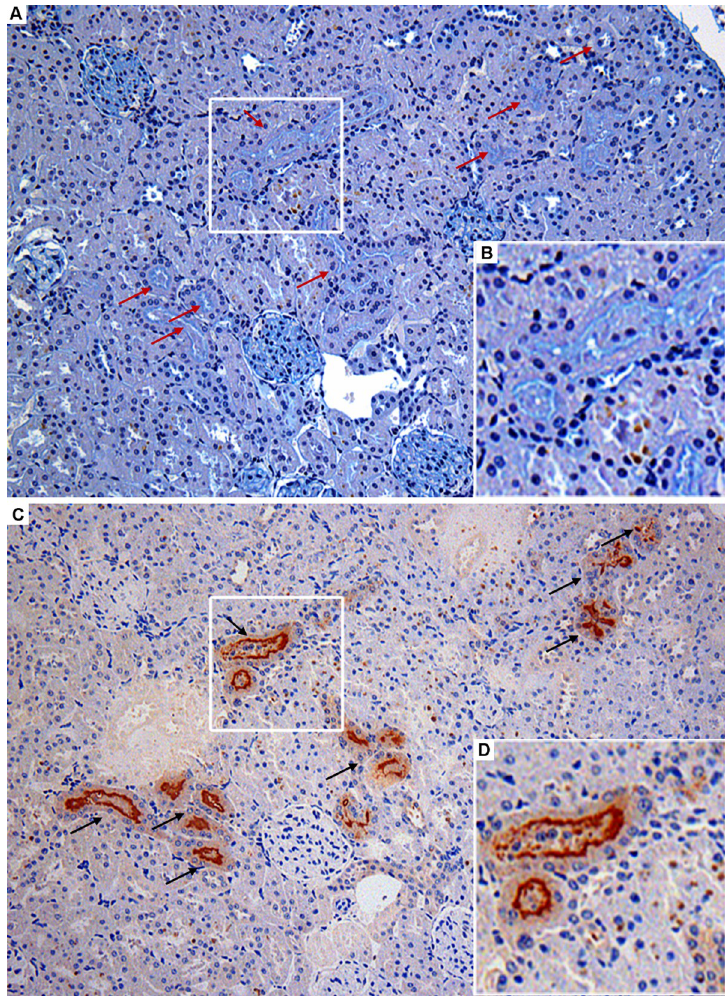
Fig 1. Histopathological investigation of leptospiral infection and biofilm formation in kidney serial sections of wild Rattus norvegicus naturally infected with pathogenic Leptospira interrogans . (A) Alcian Blue (AB) positively stained renal tubules (red arrows) observed in light turquoise blue, indicating the presence of biofilm matrix; insert B with detail of biofilm staining. (C) Renal tubules positive for IHC anti- L . interrogans demonstrating leptospiral colonization of proximal tubules (black arrows); insert D with detail of colonized tubule. Note that the serial sections showed in A and D are from the same region of one rat kidney, evidencing the co-localization of tubules concomitantly positive in AB (red arrows) and IHC (black arrows). Magnification, x